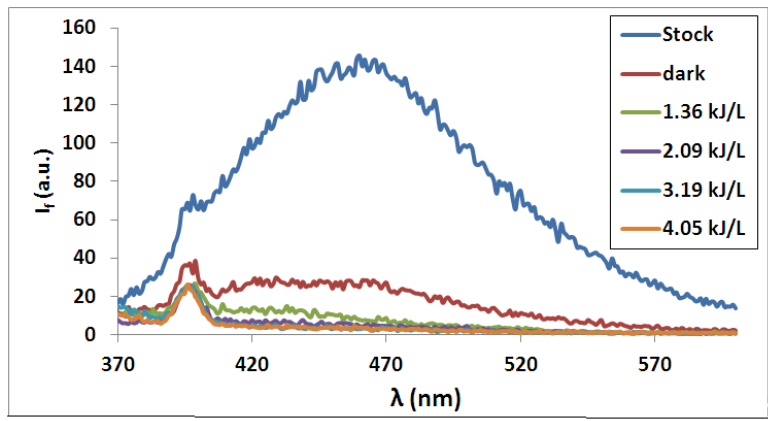
Figure 2. Degradation of FA (10 ppm) using TiO reactor, the fluorescence spectra were recorded for λ irradiation times. Irradiation times are converted to required energy per volume in (kJ/L) for the corresponding removal of FA shown on the Y